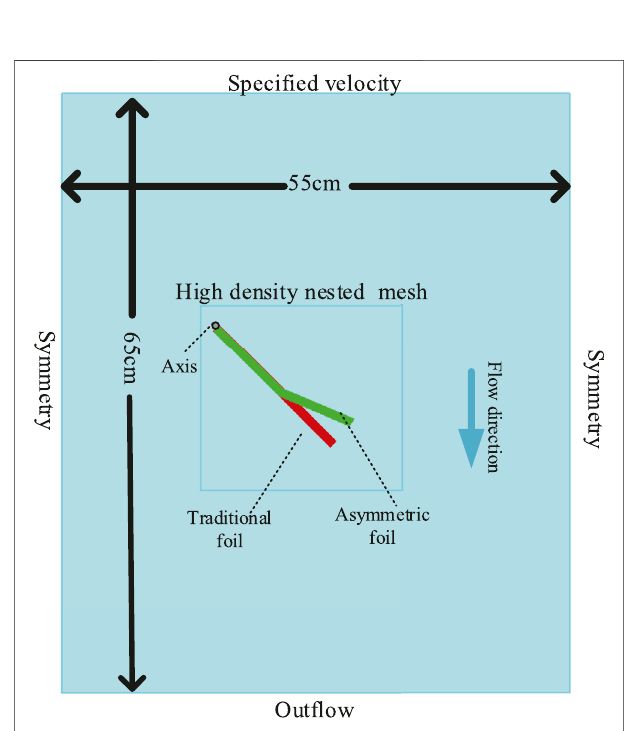
Frontiers in Robotics and AI |